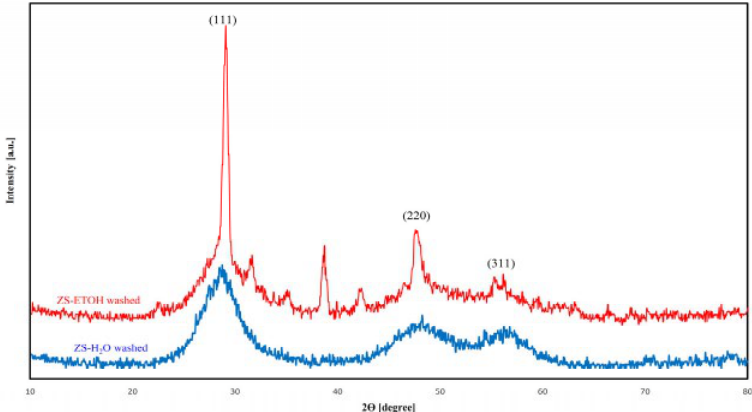
Figure 1 . XRD spectra of the synthesized ZnS nanoparticles using no surfactant agent Fig. 1. XRD spectra of the synthesized ZnS nanoparticles using no surfactant